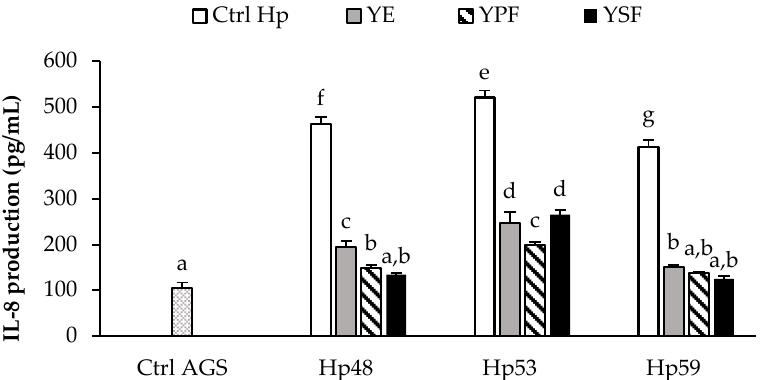
Figure 2. Inhibition effect of yarrow extract (YE) and its SAF fractions (YPF, yarrow’s precipitator fraction and YSF, and yarrow’s separator fraction) (0.08 mg/mL) on pro-inflammatory cytokine IL-8 production (pg/mL) by human gastric epithelial AGS cells infected by H. pylori strains. Control Hp (Ctrl Hp) represents the values obtained from untreated cells infected with H. pylori strains. Control AGS (Ctrl AGS) represents the values obtained from untreated and uninfected AGS cells. Values are the mean ± SD ( n = 3). a–g Different letters indicate statistical differences between treatments for each H. pylori strain ( p < 0.05).